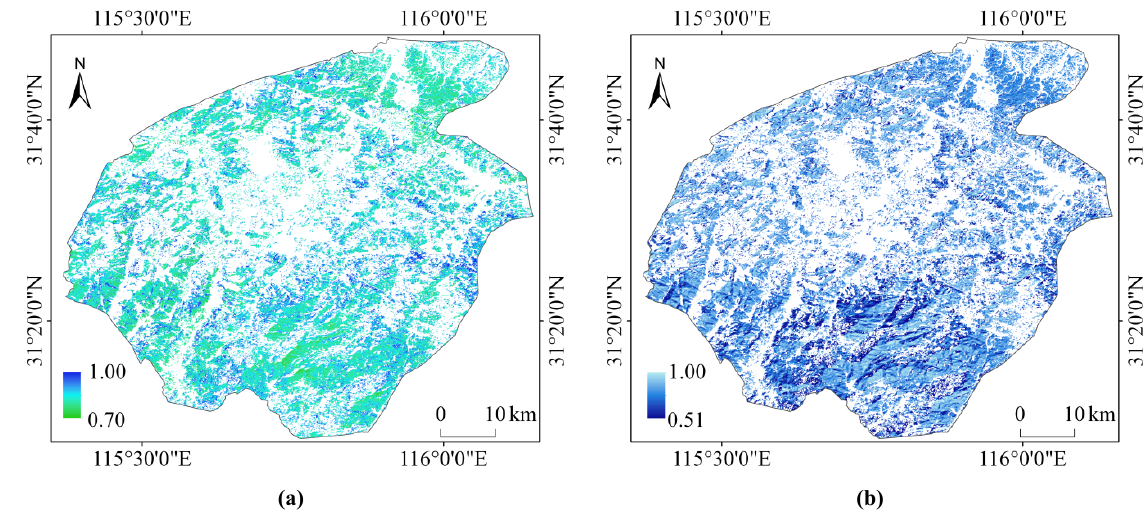
Figure 12. Distribution of fAPAR in the study area Dabie mountain in ( a ) and distribution of cos i in ( b ). Note that non-forest pixels are shown in white.